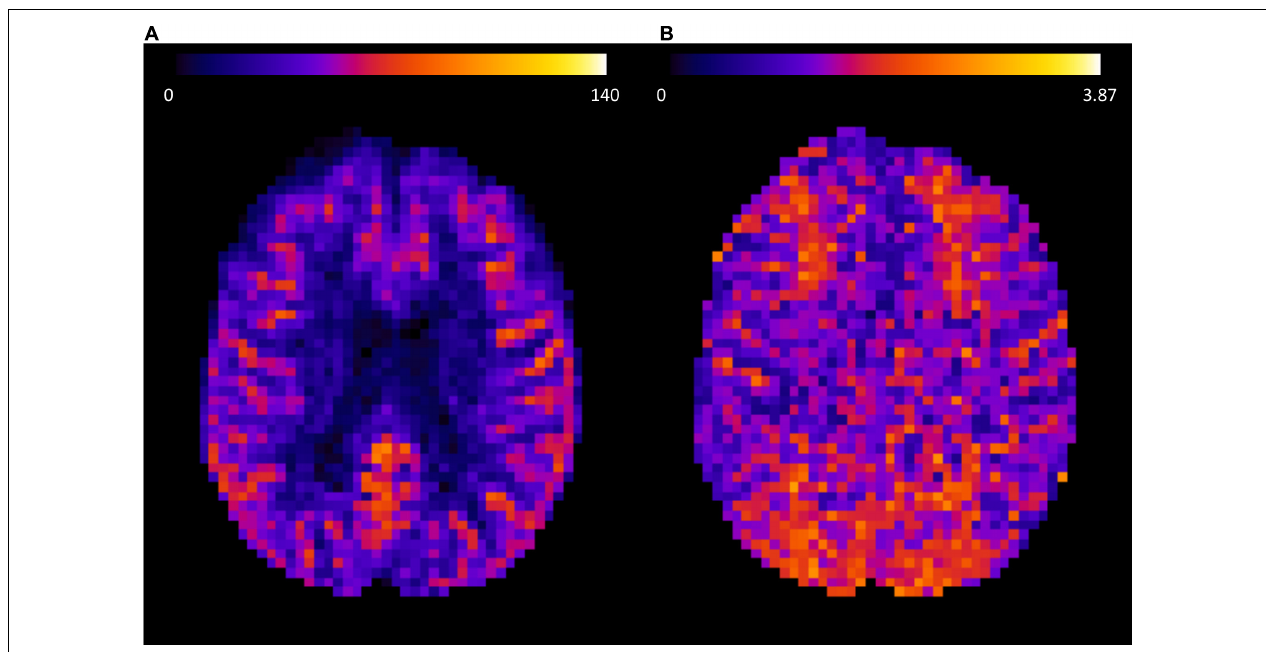
FIGURE 2 | Axial slice of the cerebral blood flow (CBF) (A) and the arterial transit time (ATT) (B) result of a representative participant obtained from a pCASL acquisition at the Skyra MRI system. To visualize gray and white matter values within the same image, estimated results before a partial volume correction was applied are shown.